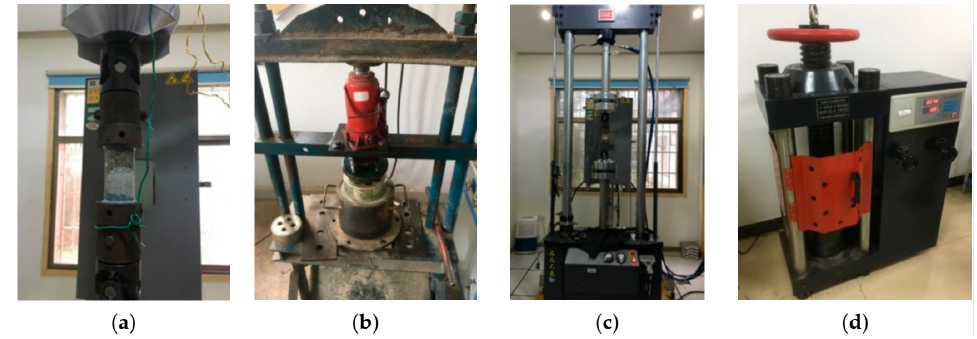
Figure 2. Overall photo of test setup: ( a ) deformability; ( b ) impermeability; ( c ) bond strength; ( d ) compressive strength